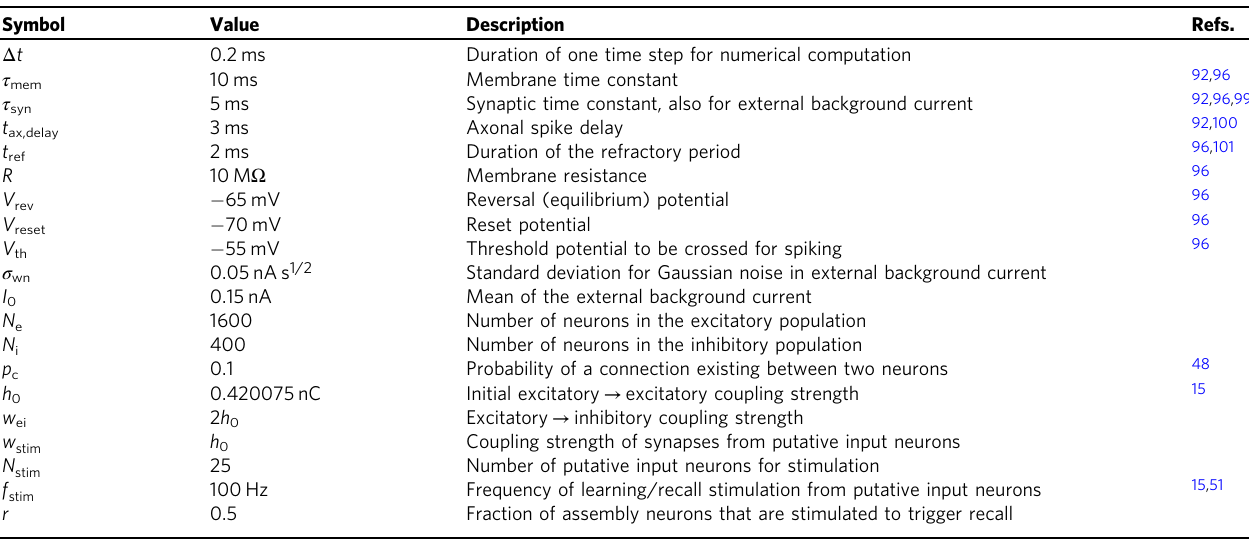
Table 1 Values were used as given in this table, unless stated otherwise. Parameters for neuron and static network dynamics